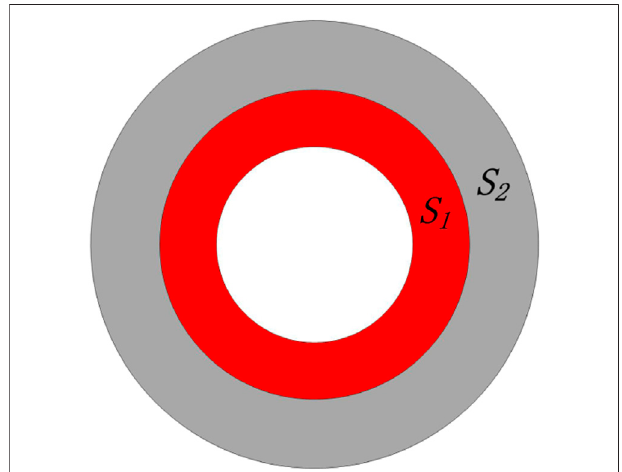
FIGURE 7 | Schematic diagram of the elastoplastic zone of the cement sheath.